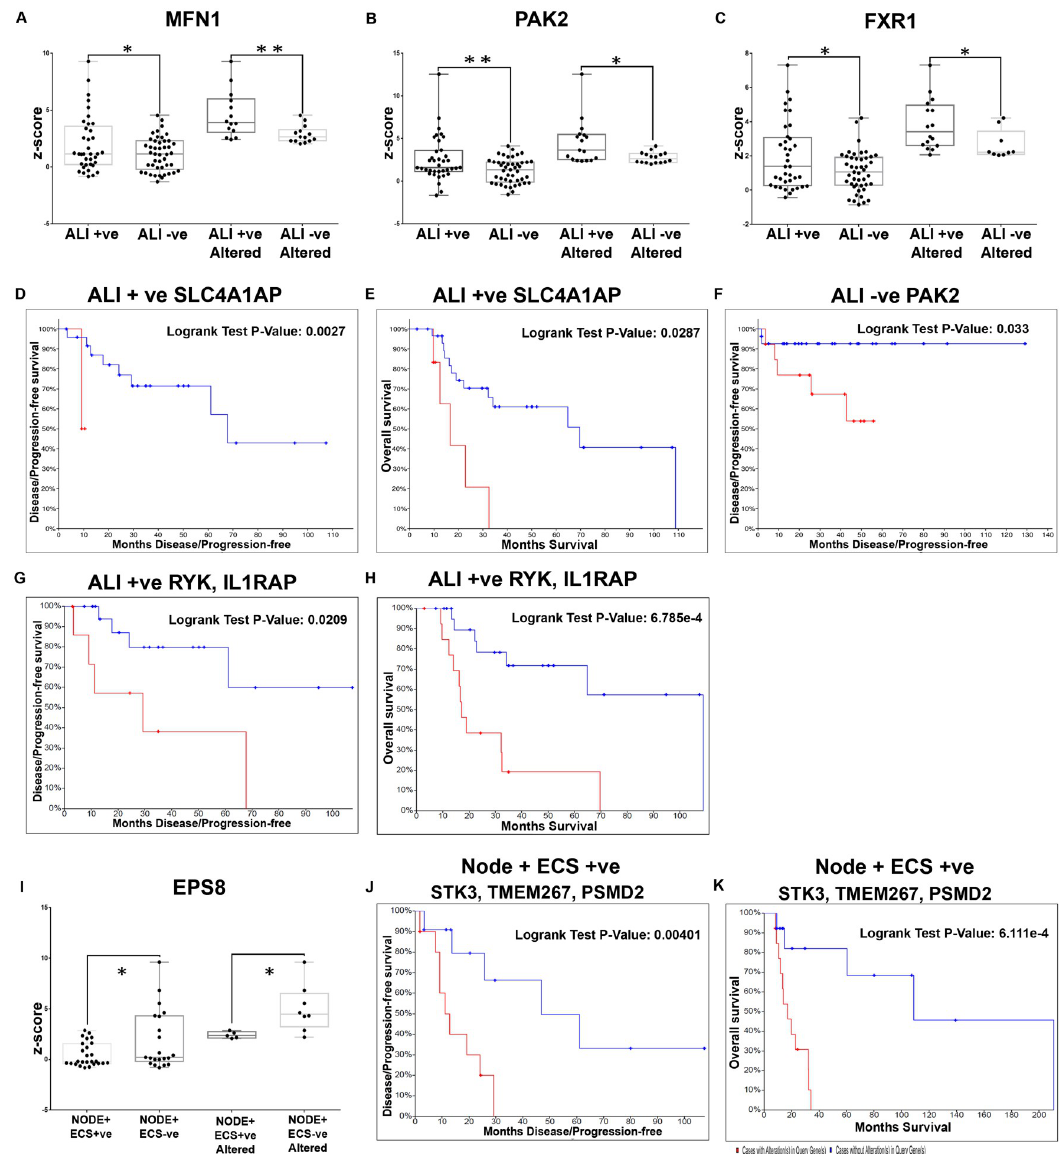
Fig 6. Molecular markers with significant differential expression and prognostic efficacy in laryngopharyngeal cancers with angiolymphatic invasion and nodal metastasis. Validation of the differentials identified in the laryngopharyngeal cancer within the TCGA cohort of patients with angiolymphatic invasion identified 4 genes with significant difference in mRNA expression levels (z- score) in TCGA cohort laryngopharyngeal cancer with ALI; the top three genes being MFN1, PAK2 and FXR1 ( A-C ). Among this cohort, SLC4A1AP showed an association in both OS ( D ; p = 0.002785) and DFS ( E ; p = 0.0287) of ALI+ patients, while PAK2 showed association with ALI- in DFS alone ( F ; p = 0.033). Prognostic assessment of the subset of meta-analysis based differentials altered in > 20% of the patients identified the combination of RYK and IL1RAP to be associated with poor survival (G and H) . EPS8 was the only differential in node in node+ECS- patients with no survival impact (I) validation of the differentials associated with node positive with/without ECS indicated that EPS8 was the only differential (downregulated) in node+/ECS+ cohort with no association with survival. Prognostic efficacy (subset altered in > 20% patients) indicated that STK3, TMEM267 and PSMD2 were the prognosticators of poor survival (J and K) . (P-value; � p < 0.05; �� p < 0.005).